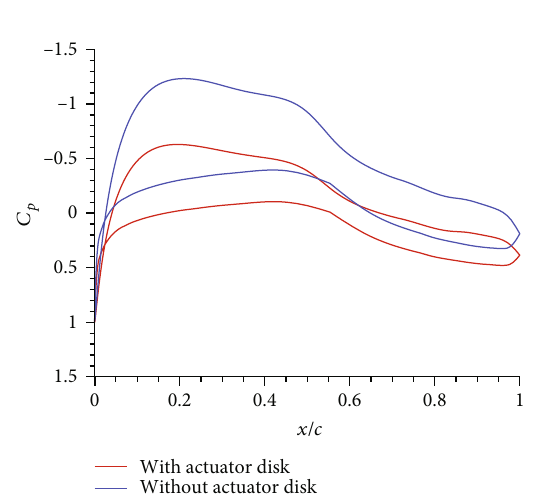
Figure 15: Pressure contours and streamlines in helicopter mode.